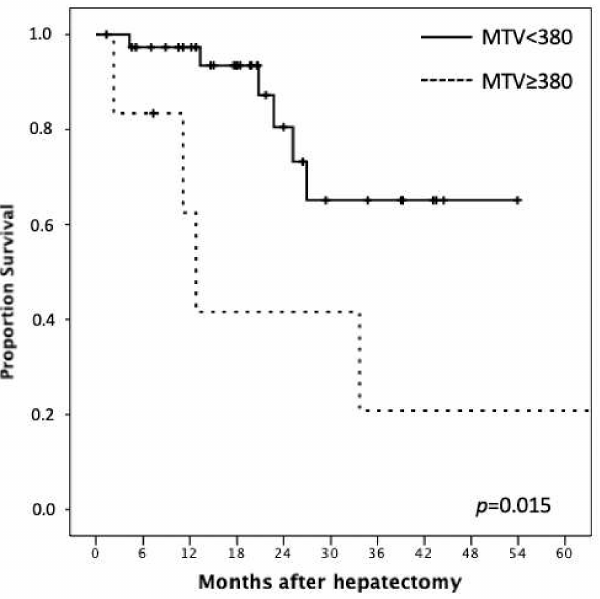
Figure 3. The figure shows the Kaplan–Meier curve for OS in relation to cut-off value for metabolic tumor volume (MTV): the 3-year OS rates were 62% and 20% for patients with MTV < 380 and MTV ≥ 380, respectively ( p =